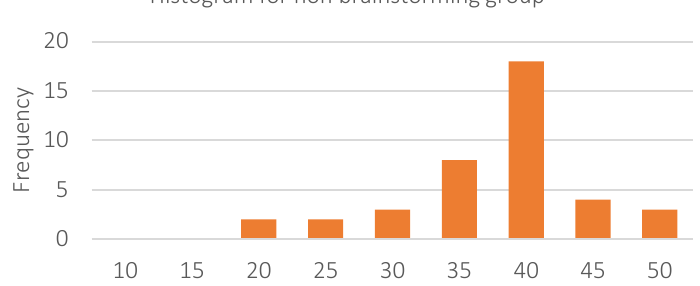
Figure 3. Normality histogram (non-brainstorming group)